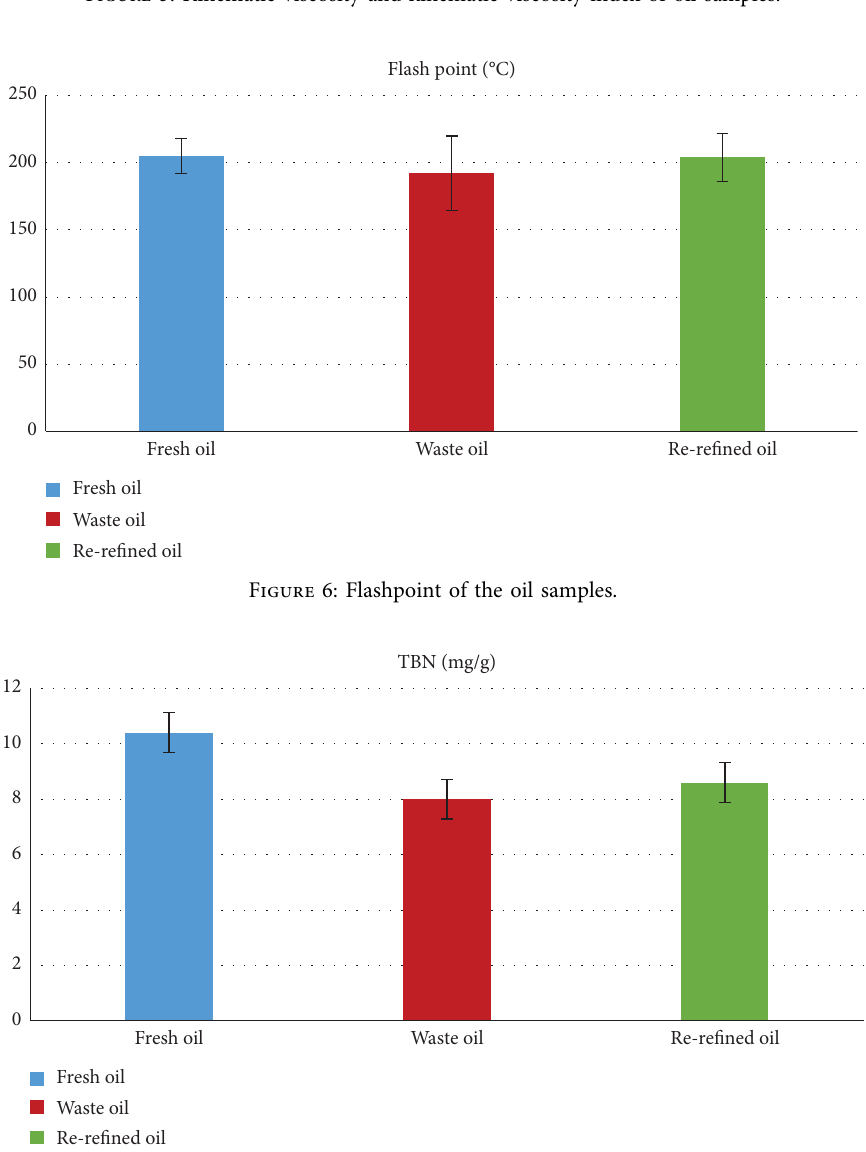
Figure 7: Total base numbers of oil samples.